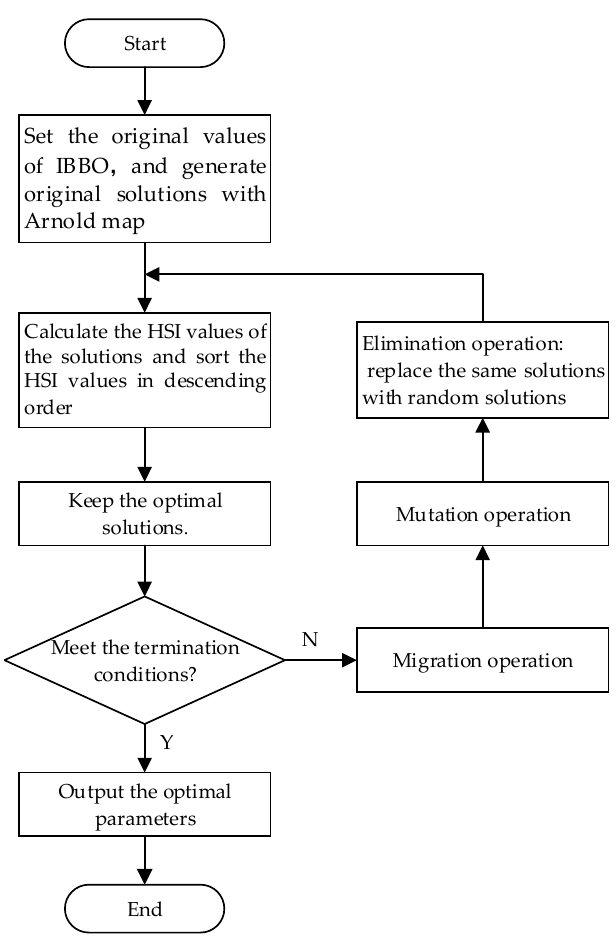
Figure 3. Flow chart of improved Biogeography-Based Optimization (IBBO).